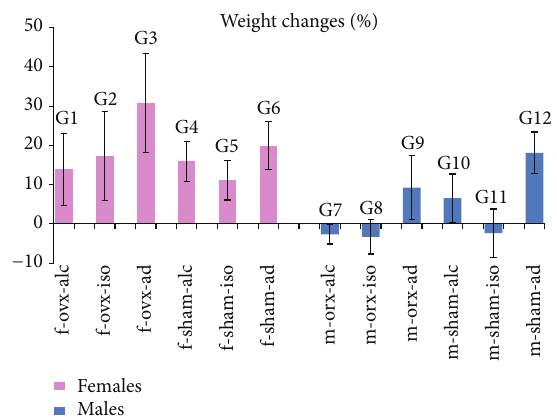
Figure 1: Weight changes (%): the graph illustrates the values of the averages (bars) and standard deviations (lines superimposing the bars). Statistical comparisons are summarized as follows: females: comparison between most of the groups showed no significant differences (NS). Statistical significances ( 𝑝 < 0.05 ) ( ∗ ) were observed in the following groups: G1/G3 ( ∗ ); G2/G3 ( ∗ ); G4/G3 ( ∗ ); G5/G3 ( ∗ ). Males: comparison between most of the groups showed no significant differences (NS). Statistical significances ( 𝑝 < 0.05